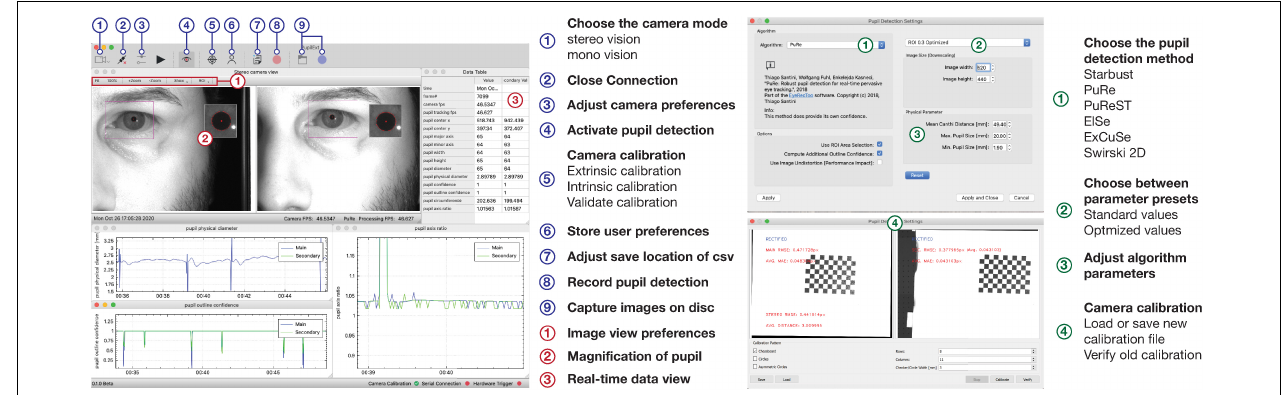
FIGURE 7 | The graphical user interface of the programmed software PupilEXT during a pupil recording in stereo camera mode. In the main window’s taskbar, various functions can be accessed for quick actions. In the pupil detection sub-window, a pupil algorithm with respective parameters can be adjusted. The camera calibration can be done directly in PupilEXT . Calibration files can be saved and validated to give an outline of the camera system’s edge detection accuracy, which is essential for a pupil measurement